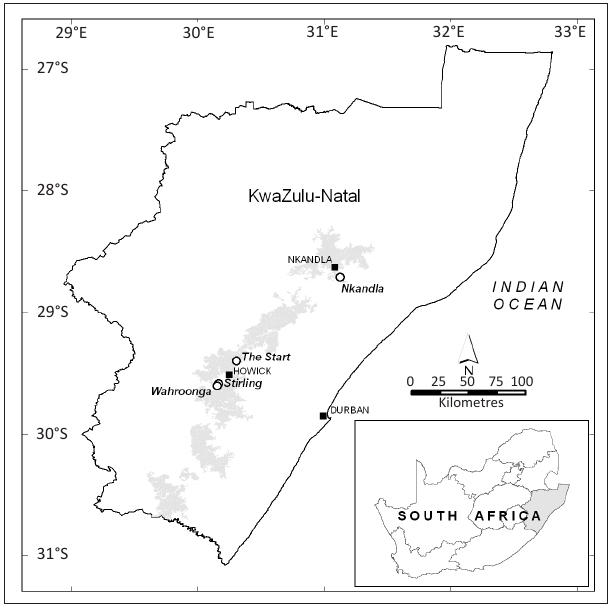
FIGURE 1: Location of the four known colonies of Orachrysops ariadne in relation to the original extent of the Moist Midlands Mistbelt vegetation type and two urban areas.